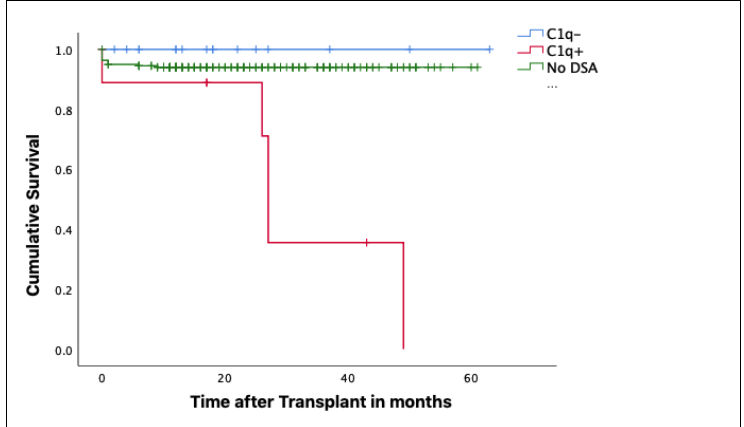
Figure 3. Kaplan – Meier curves to determine renal graft survival according to C1q-binding capacity by dnDSAs. Lower renal graft survival is observed in patients who develop complement-binding dnDSAs, whereas survival is similar for the other two populations.